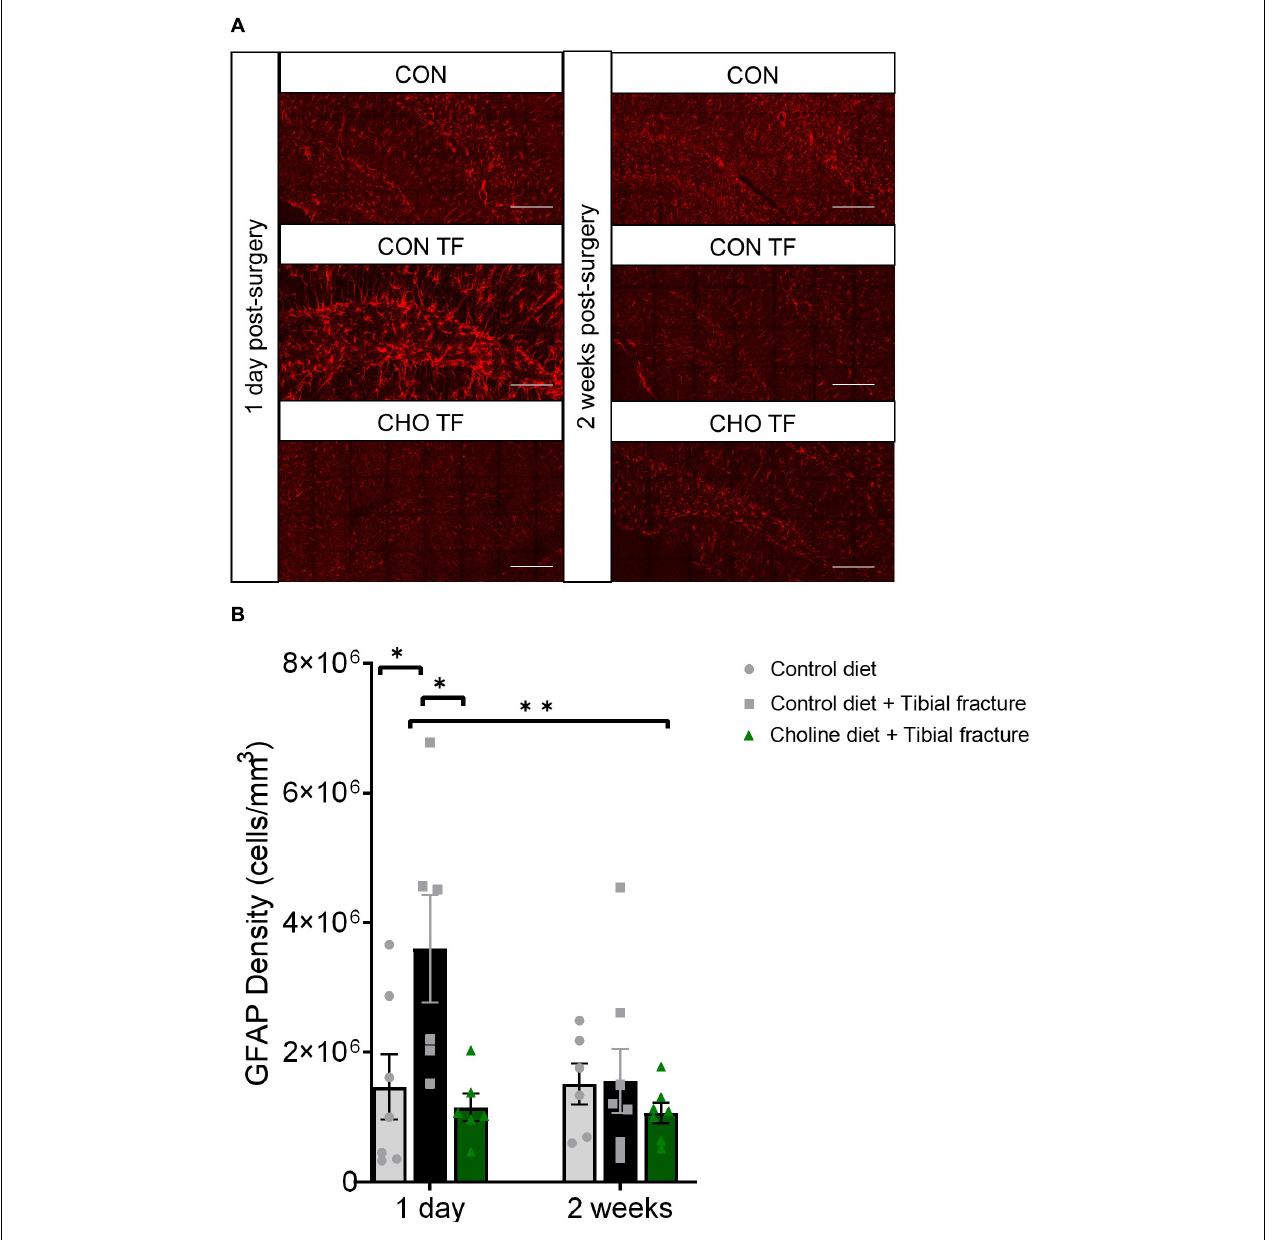
FIGURE 6 | Tibial fracture and choline diet effects on astrocytic density. (A) Representative fluorescent micrographs of the dentate gyrus taken 1 day and 2 weeks after surgery, immunostained with glial fibrillary acidic protein (GFAP). Images are maximum intensity projections of the full Z-stack. CON, control diet + naïve; CON TF, control diet + tibial fracture surgery; CHO TF, choline diet + tibial fracture surgery. Scale bar: 100 µ m. (B) Histogram showing the antigen density of GFAP in the dentate gyrus of the hippocampus. ∗ p < 0.05, ∗∗ p < 0.01, Tukey HSD. Each bar represents the mean ± SEM. N = 6–8 per